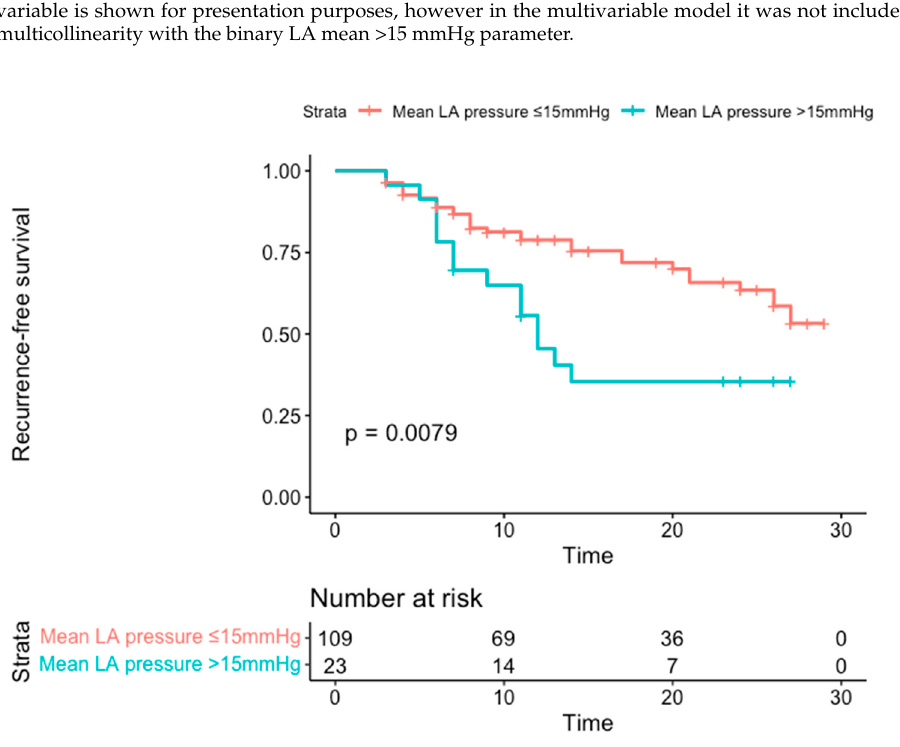
Figure 1. Kaplan-Meier survival curves for patients dichotomized in mean left atrial pressure >15 mmHg and ≤ 15 mmHg according to the receiver operating characteristics.